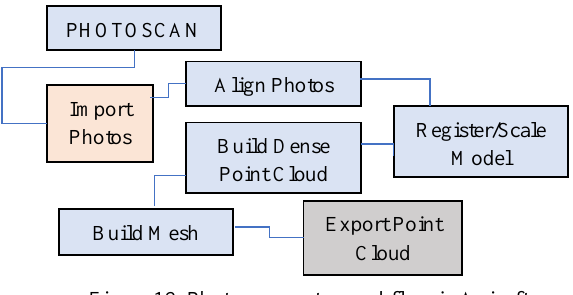
Figure 12. Photogrammetry workflow in Agisoft Photoscan (CIMS, 2018)